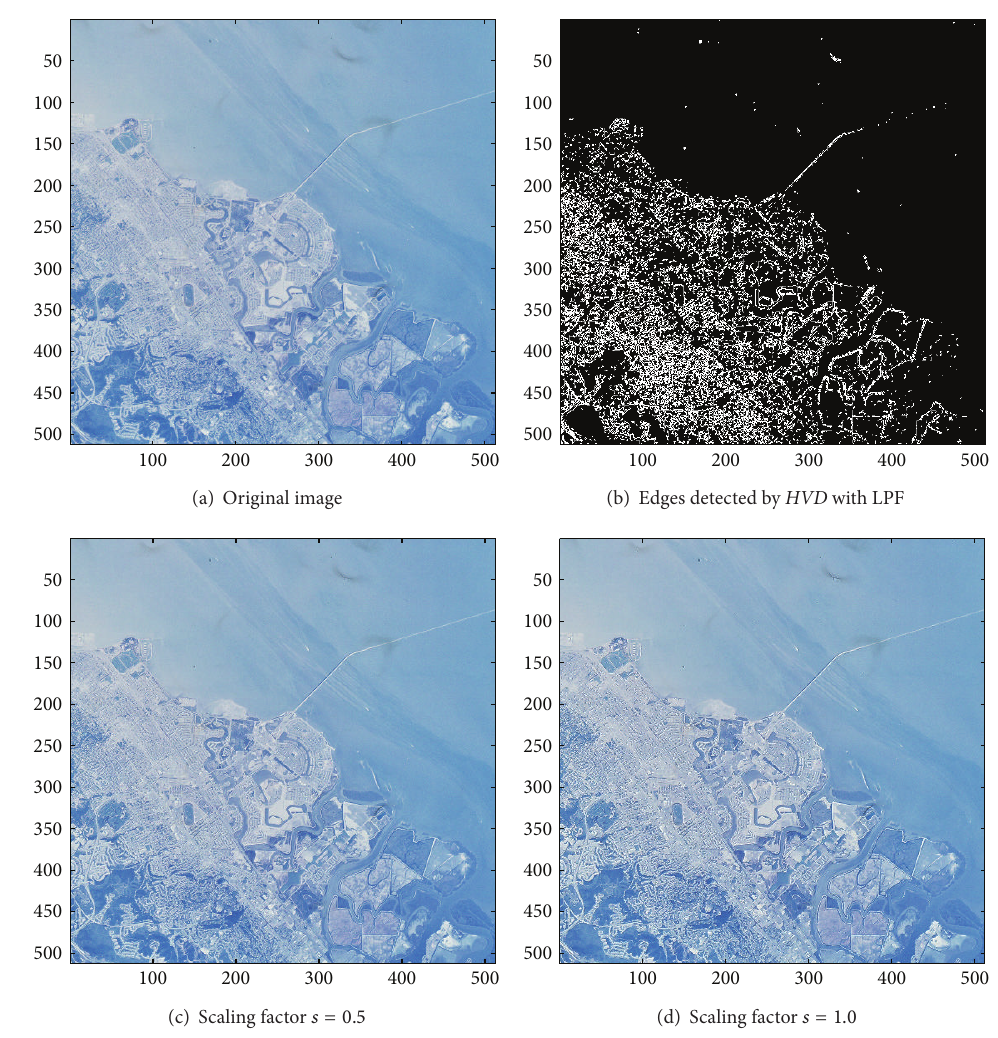
= 9 for HVD .(a)Theimage“FosterCity,CA”(512 × 512colorimage).(b)Edgesdetectedby HVD withLPF.(candd)Sharpened Figure12: 𝜃 eth results by HVD with scaling factors 0.5 and 1.0 ,